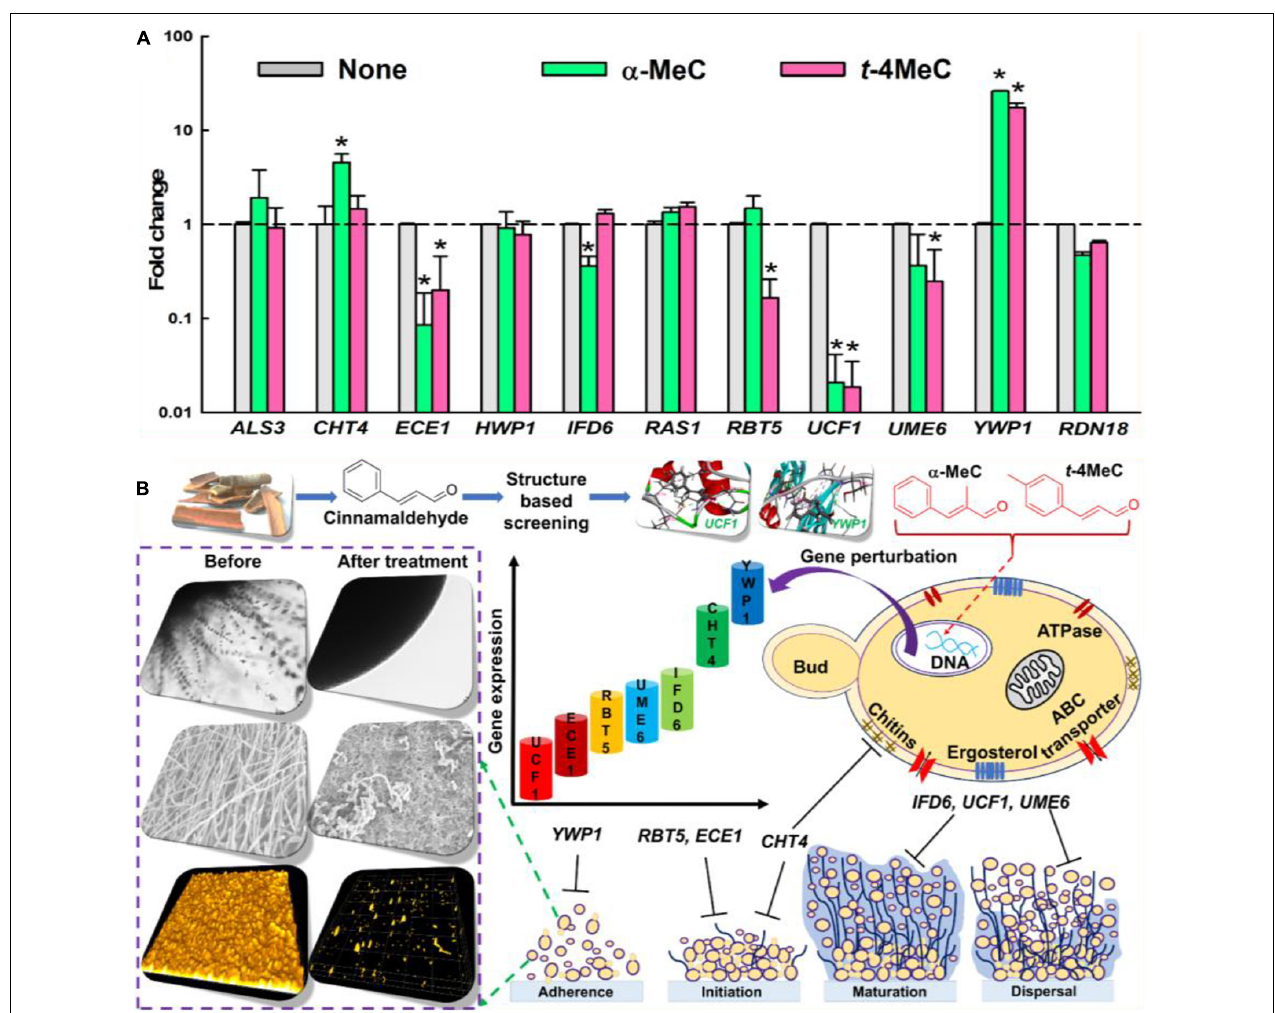
FIGURE 4 | The relative transcriptional profile of ten biofilm- and hypha-related genes. C. albicans DAY185 cells incubated with or without α -methyl cinnamaldehyde ( α -MeC) or trans- 4-methyl cinnamaldehyde ( t -4MeC) at 50 µ g/mL for 6 h and relative transcriptional expressions profiles were obtained by qRT-PCR. Fold changes represent alteration in the transcription of treated vs. untreated C. albicans DAY185. RDN18 was used for endogenous normalization of expression levels and the experiment was performed in duplicate (six qRT-PCR reactions were performed per gene) (A) . A plausible mechanism of C. albicans biofilm inhibition by α -methyl cinnamaldehyde ( α -MeC) and trans- 4-methyl cinnamaldehyde ( t -4MeC) illustrating all the phenotypic and gene expressional changes (B). Error bars indicate standard deviations. * P < 0.05 vs. non-treated controls